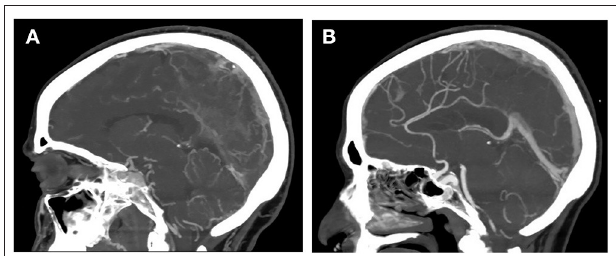
FIGURE 1 | CT cerebral venography showing massive cerebral venous thrombosis associated with COVID-19 infection. (A) At admission. (B) After 3 weeks of anticoagulation therapy.